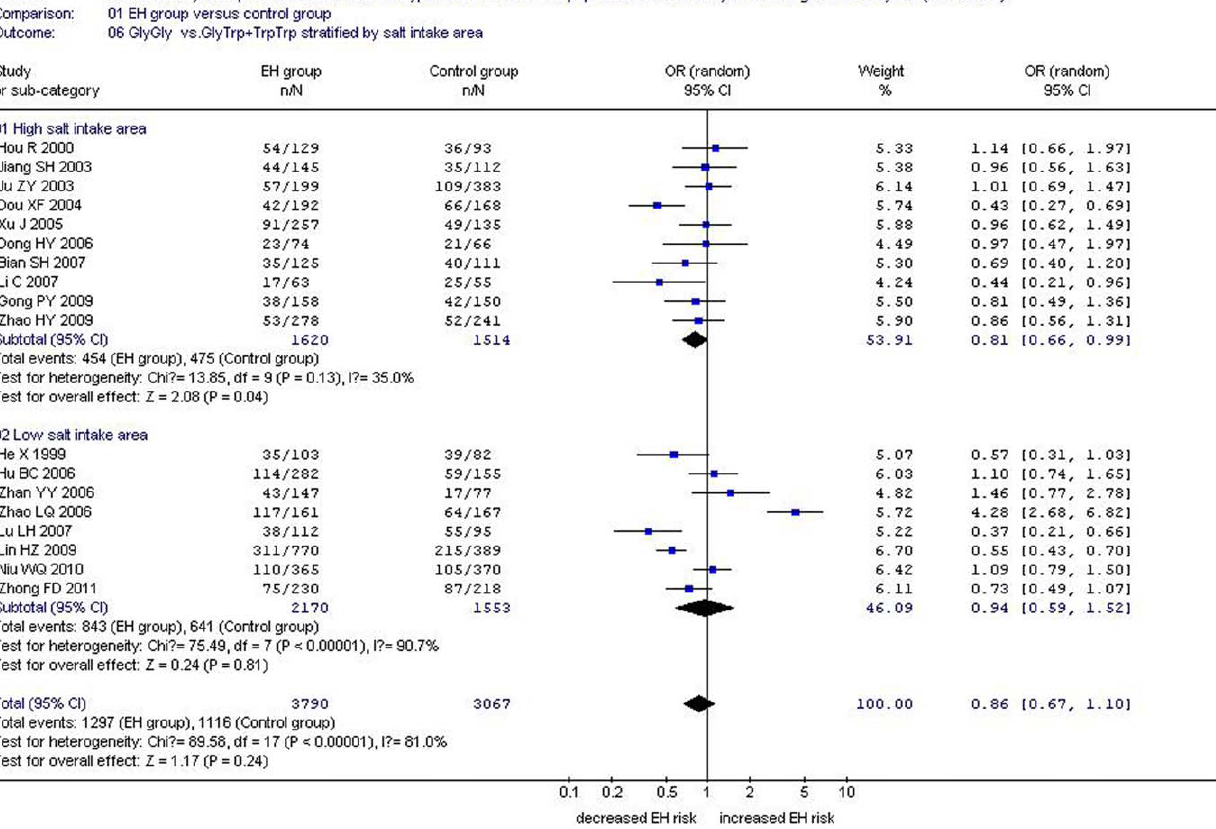
Figure 7. Forest plot of essential hypertension associated with a -adducin Gly460Trp gene polymorphism under a dominant genetic model (GlyGly vs. GlyTrp + TrpTrp) stratified by salt intake area in Chinese Han population.